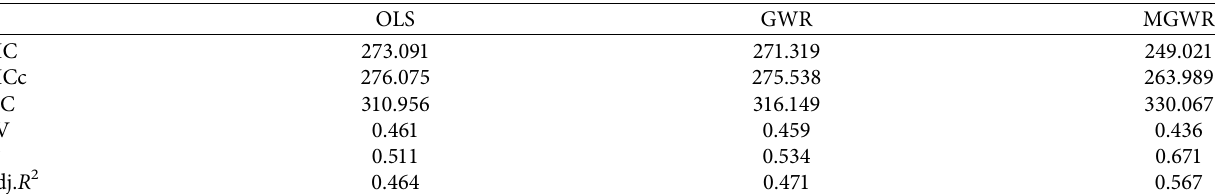
Table 5: Comparison of the results of the three